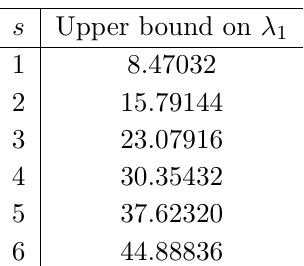
Table 2 . Upper bounds on the spectral gap from consistency conditions of quadruple overlap integrals of a holomorphic s -differential with J = 30 , i.e., with 60 − 4 s derivatives. nondegenerate, nonzero eigenvalue of the Bolza surface is λ